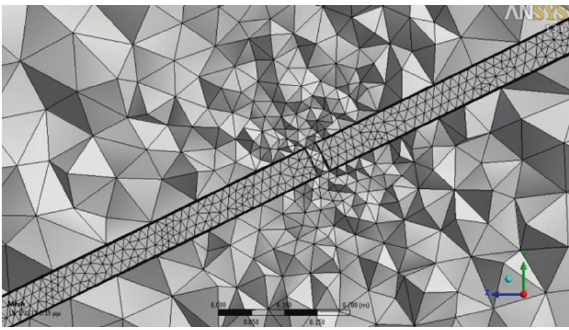
Figure 6: Computational grid gap details between solar panels. Table 2: Approach azimuthal angles and velocity range for compu- tational analysis.